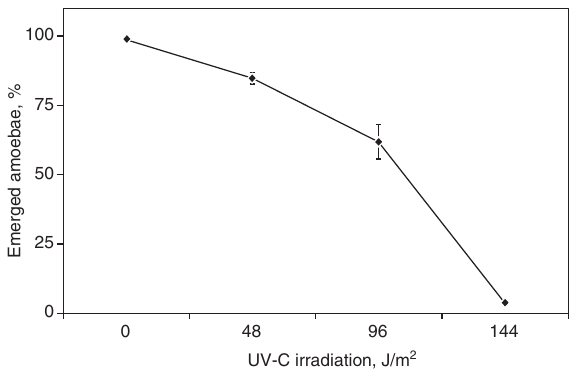
Figure 2 Germination activity of the spores washed before UV-C irradiation. Other procedures are described in the legend for Figure 1. Data points represent the means of two or three experi- ments with standard